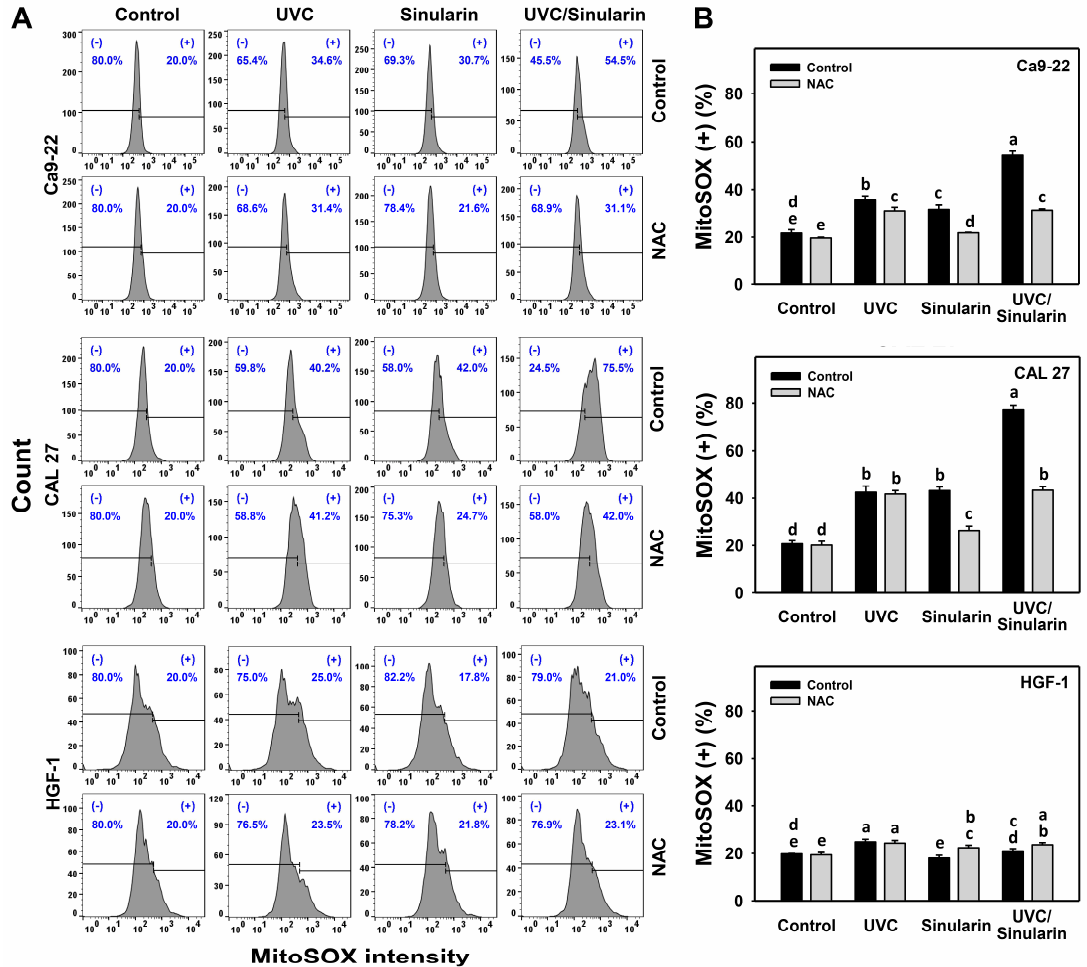
Figure 6. MitoSOX expressions of UVC and/or sinularin treatments. Following the NAC preincubation (5 mM for 1 h) or not, the cells were arranged into four kinds of treatments: the control (0.1% DMSO in medium), UVC, sinularin, and UVC/sinularin for 48 h. The UVC and/or sinularin conditions were 12 J/m 2 , 2 μM and 10 J/m 2 , 3 μM for oral cancer cells (Ca9-22, CAL 27), and 12 J/m 2 , 3 μM for normal cells (HGF-1) for 48 h, respectively. ( A , B ) Patterns and quantifications for the MitoSOX analysis. (+) indicates MitoSOX-positive (%). For the multi-comparisons, the treatments marked without repeated characters (a to e) differ significantly ( p < 0.05). The data were plotted as the mean ± SD ( n = 3).